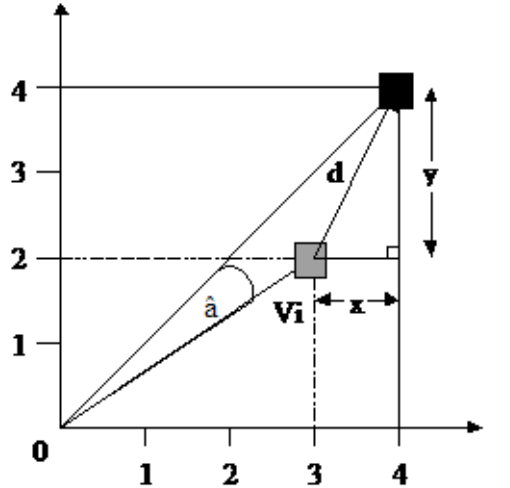
Figure 6 . Distance determination for the ordered pair (3.2) in relation to maximum interaction point (4,4)